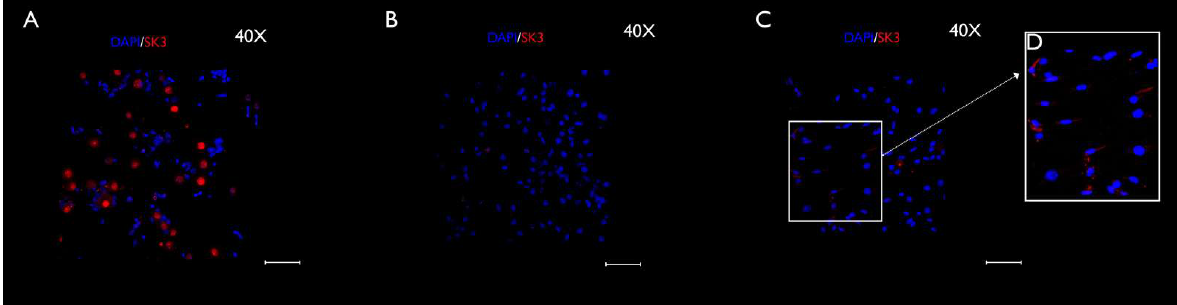
11 Figure 8. Migration velocity of SGCs. 3.3. Immunocytochemistry Evaluation The neurons and SGCs were differentiated by immunocytochemistry. The SGCs were identified by immunostaining for SK3, which has been used as a specific marker of SGCs in vivo , and βIII-tubulin, a typical neuronal marker, both in vivo and in vitro. More- over, DAPI staining contributed to differentiating the neurons and SGCs by nuclei sizes. For instance, neurons showed large and faintly stained nuclei, whereas SCGs exhibited small and bright nuclei. Immunocytochemistry revealed changes in SK3 staining over time (Figure 9A–C). The SK3 immunostaining was more intense at the early evaluation (4 h), decreasing at the subsequent stage (24 h), and then rising again during the last period of evaluation (48 h) (Figure 9A–C). A statistically significant difference was found in the quantification of the immunostaining during the study period (4 h vs. 24 h), as follows: 4